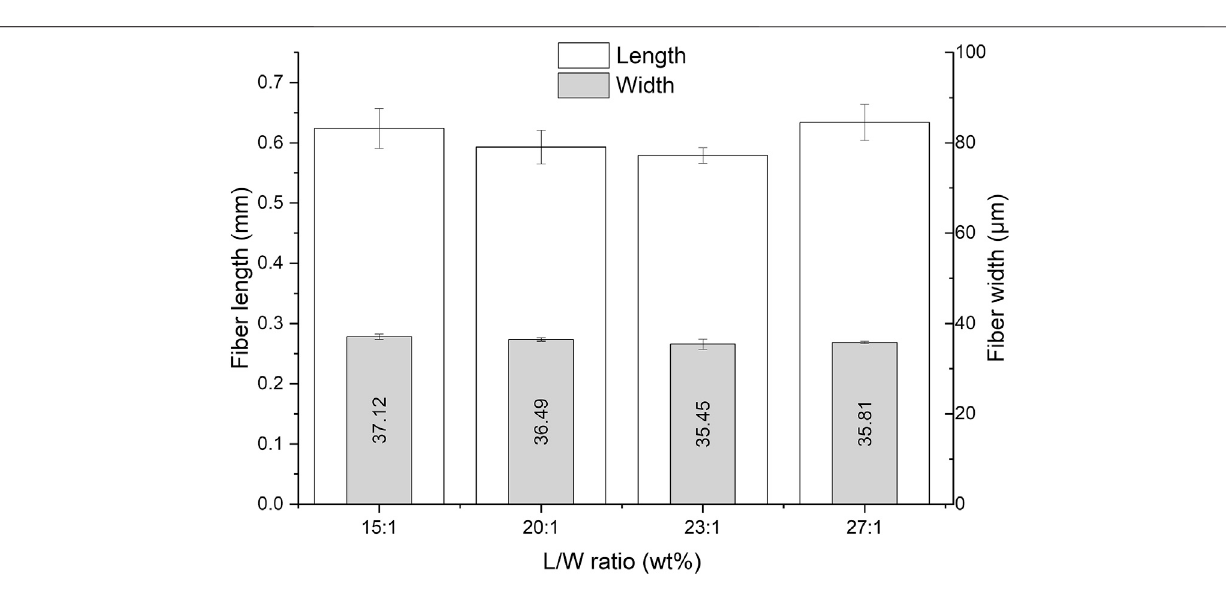
Frontiers in Chemistry |